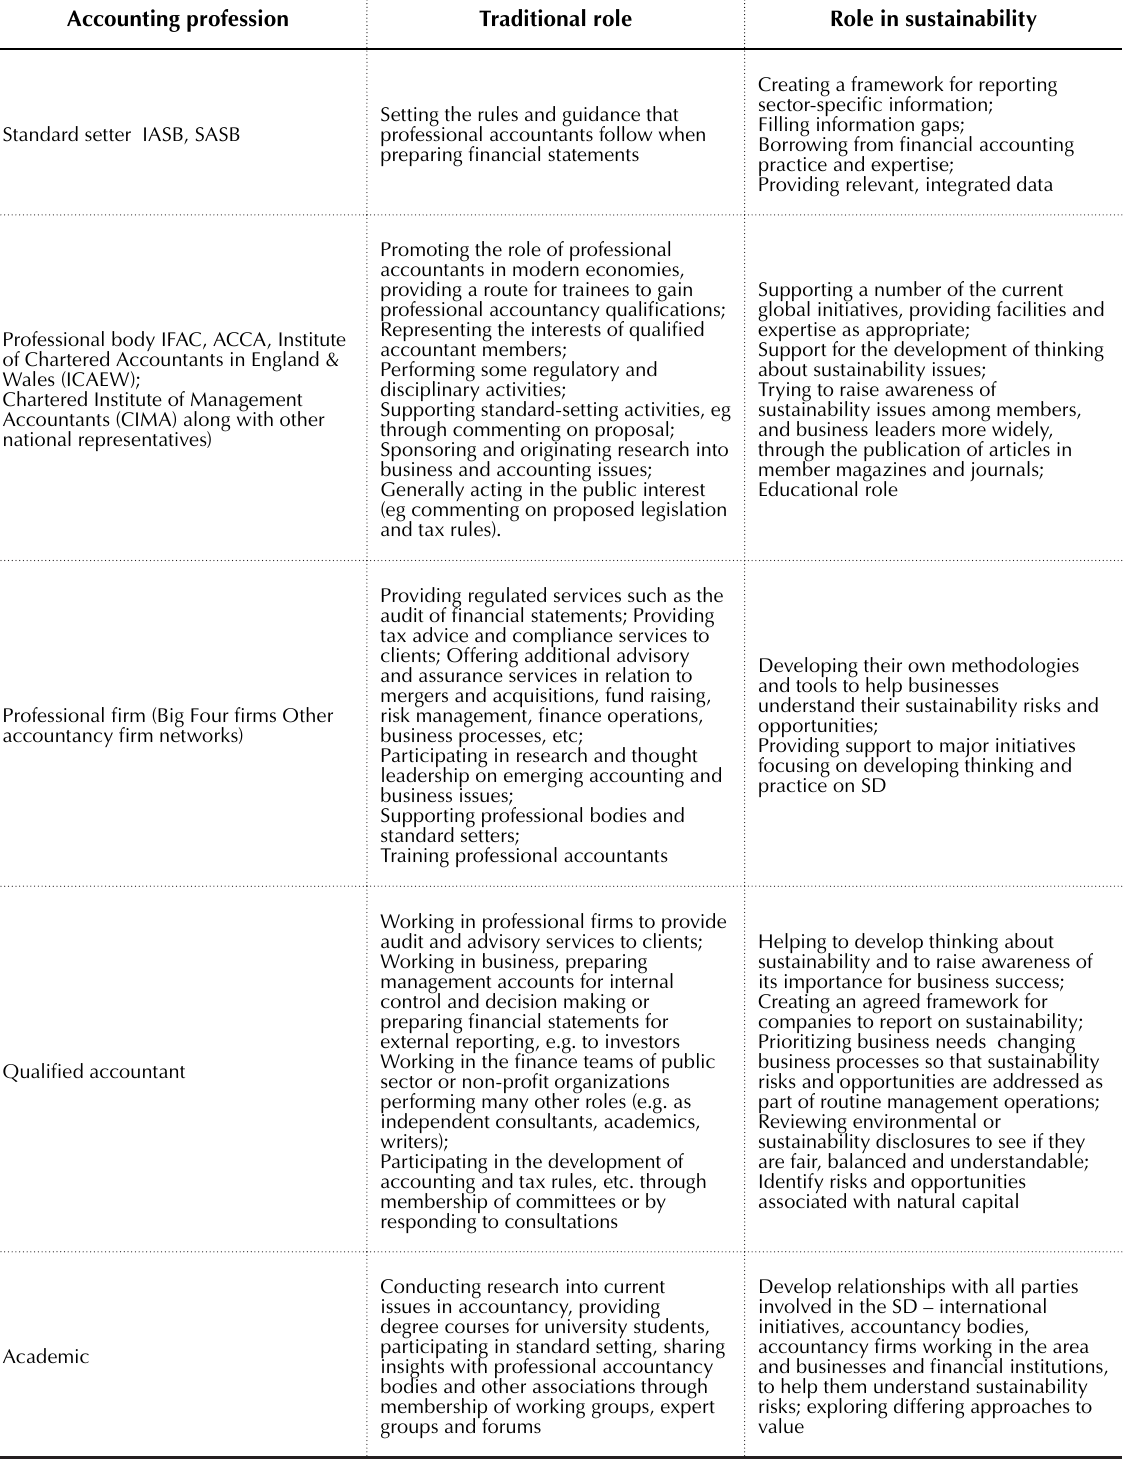
Table 4. Accountancy profession group role in traditional and sustainable